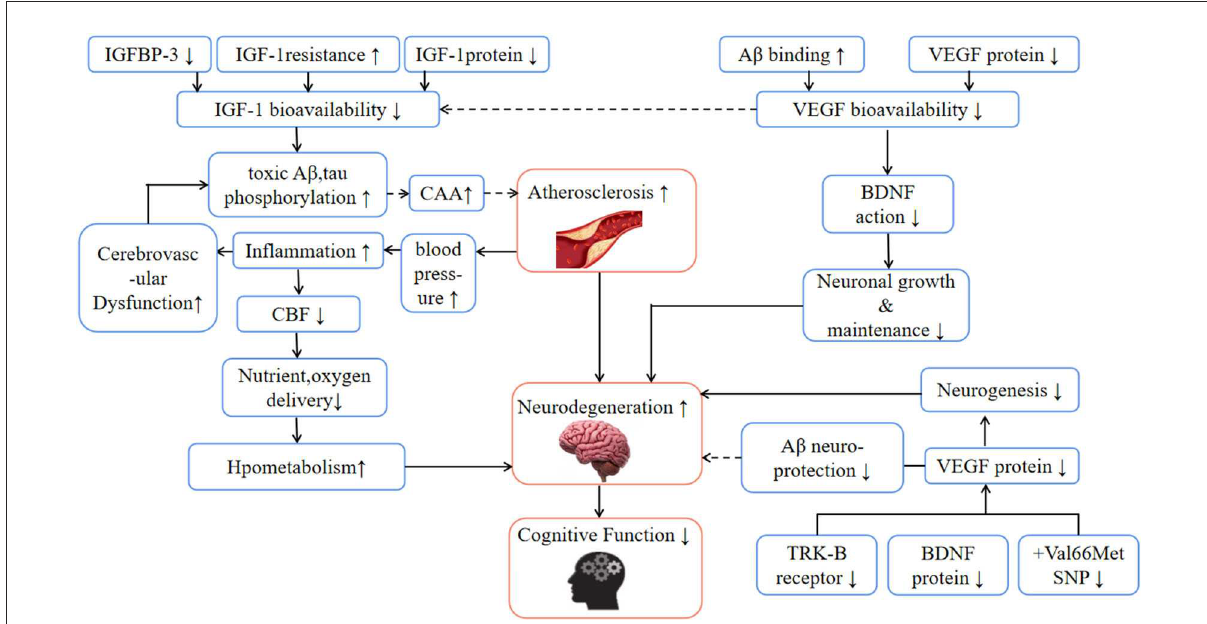
FIGURE4 The effects of aging and neurodegenerative diseases on physiological mechanisms related to cognitive health. A β , amyloid β ; BDNF, brain-derived nerve factor; CAA, cerebral amyloid angiopathy; CBF, cerebral blood flow; IGF-1, insulin-like growth factor 1; IGFBP-3, insulin-like growth factor binding protein 3; TRK-B, tropomyosin-related kinase b; SNP, single nucleotide polymorphism; VEGF, vascular endothelial growth factor; Hypothetical pathways are marked